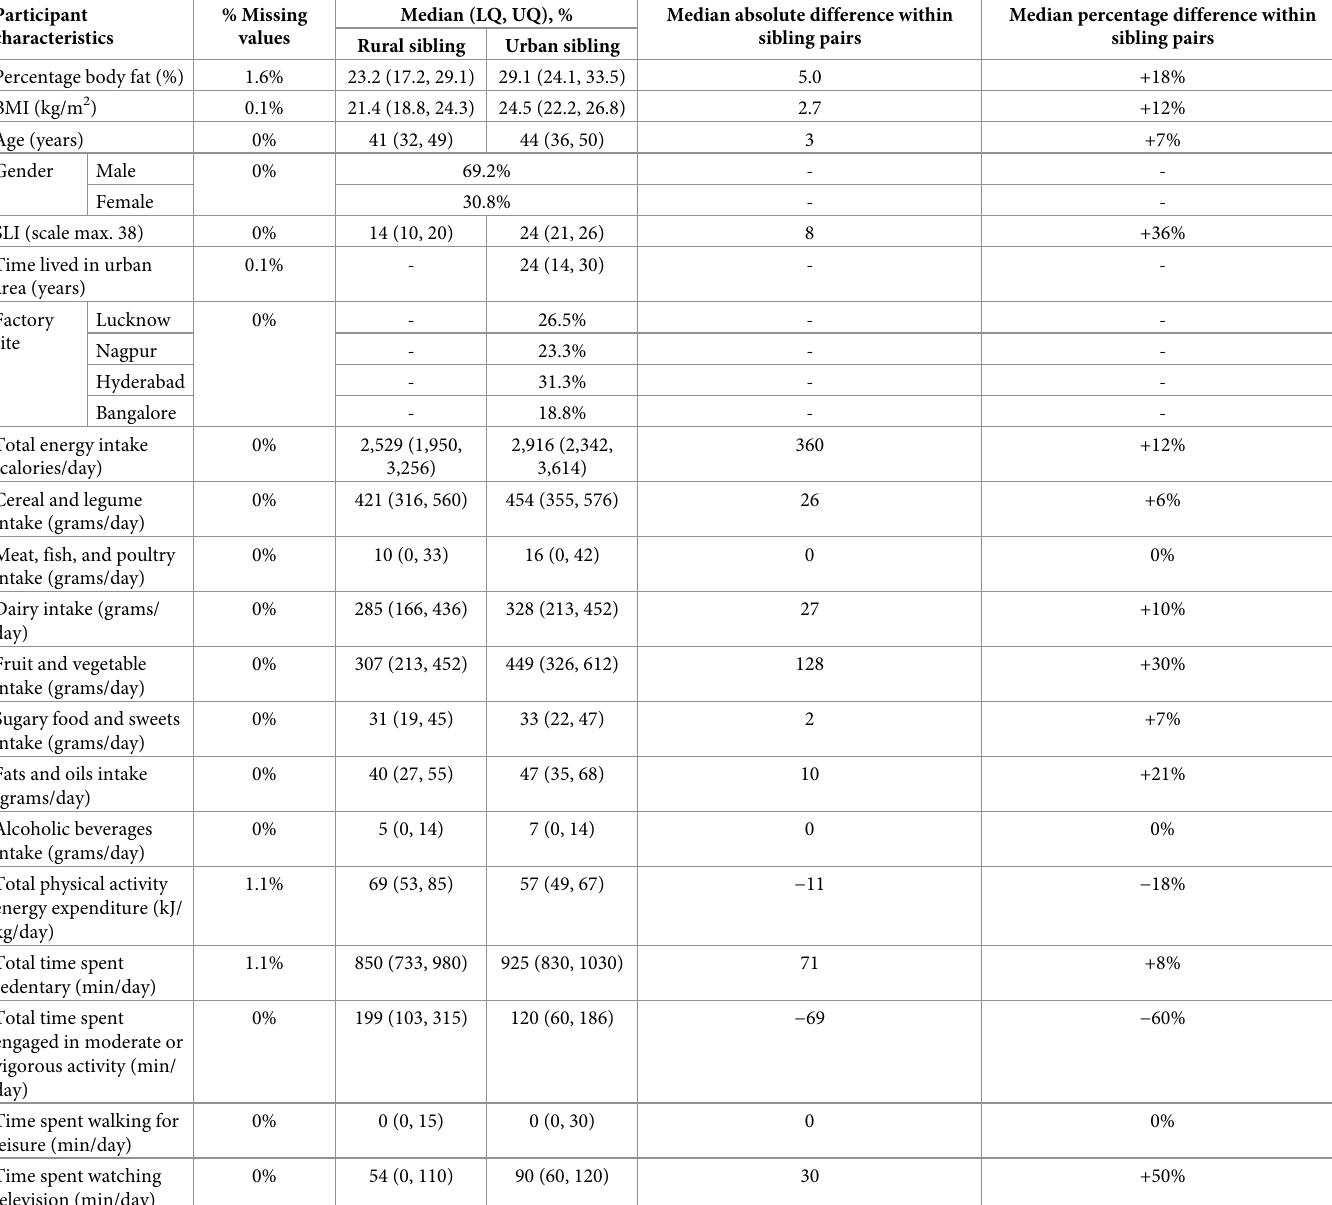
Table 1. Distribution of diet, activity, and obesity in 1,232 same-sex rural-urban migrant sibling pairs ( N = 2,464 participants) of the Indian Migration Study, 2005 to 2007. Participant